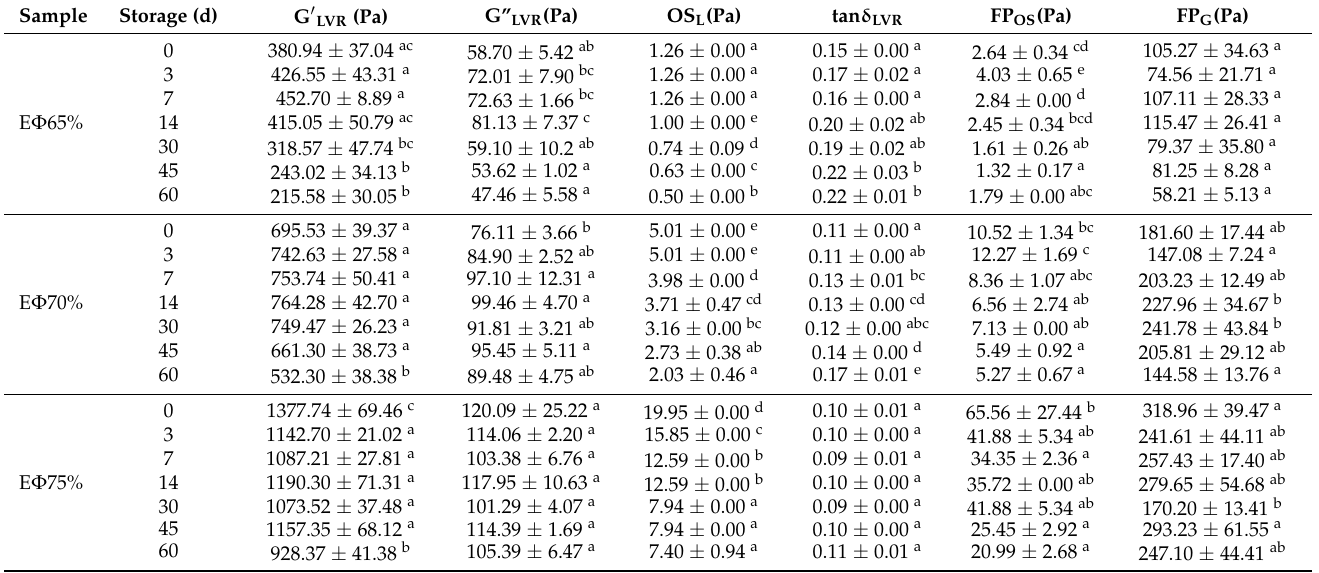
Table 3. Rheological parameters of storage (G (cid:48) LVR ) and loss (G” LVR ) moduli at the linear viscoelastic region (LVR), limiting value of oscillatory stress (OS L ), the loss-tangent (tan δ LVR ) at the LVR, flow- point oscillatory stress (FP OS ), and flow-point G (FP G ) as determined by stress sweep tests (at a 1 Hz frequency) for samples stored at 25 ◦